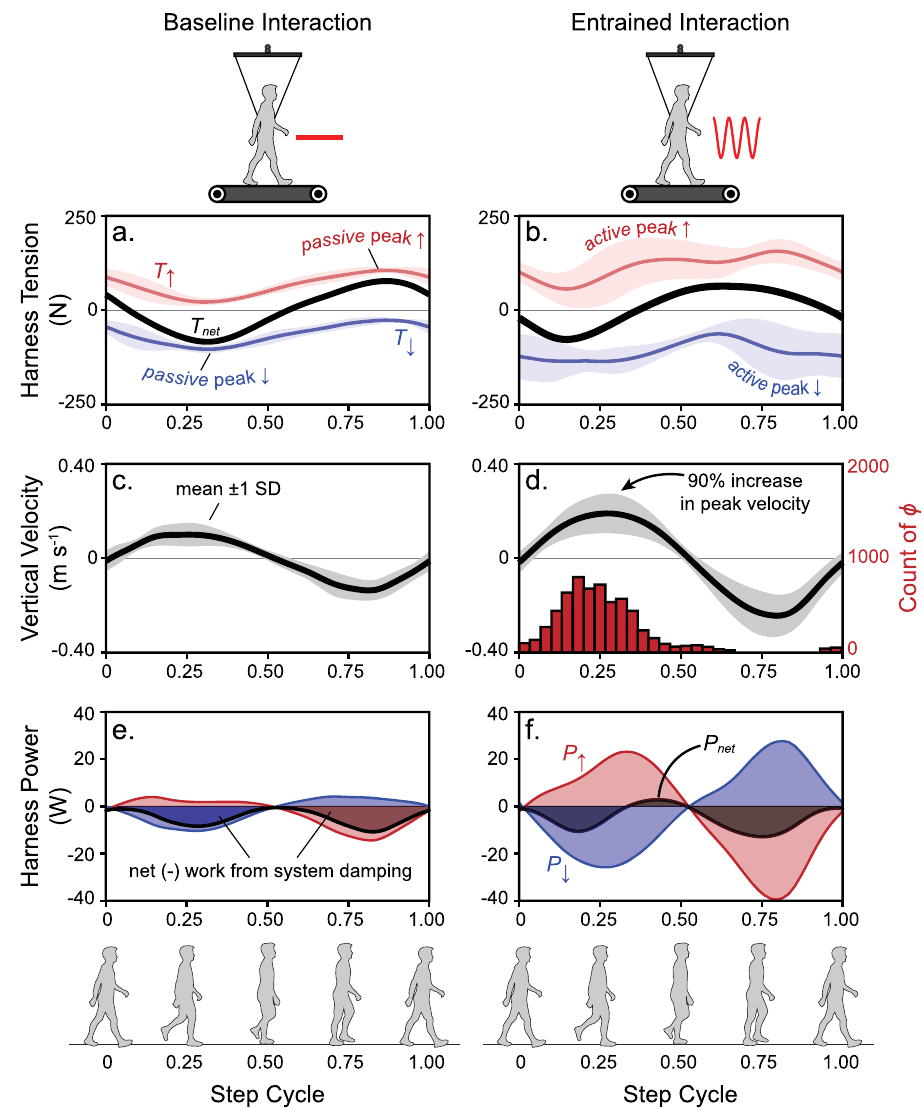
Figure 6. Subjects prefer to align peak oscillation forces after toe off. The average harness tension is shown in ( a ) and ( b ), where the red and blue curves indicate cable tension pulling up ( T ↑ ) and down ( T ↓ ), respectively, and black indicates net tension ( T net ). Average center-of-mass vertical velocity is shown in ( c ) and ( d ), while the red histogram in ( d ) indicates the distribution of motor phase chosen by subjects during entrainment. Average power from the cables pulling up ( P ↑ , red) and down ( P ↓ , blue) are shown in ( e ) and ( f ), while net power ( P net ) is shown in black (shading underneath the power curves represents work done by the harness forces on the person, after integration). Panels ( a ), ( c ) and ( e ) indicate mean curves (shading represents ± 1 intersubject standard deviation, SD) measured during Baseline 2 (walking with the harness but no active oscillations), while panels ( b ), ( d ) and ( f ) indicate mean curves ( ± 1 SD) measured during experiment trials. Snapshots of the walking step cycle are shown near the bottom to help orient the reader to the timing of events shown in plots. Zero in the step cycle corresponds with double stance while 0.5 corresponds with single